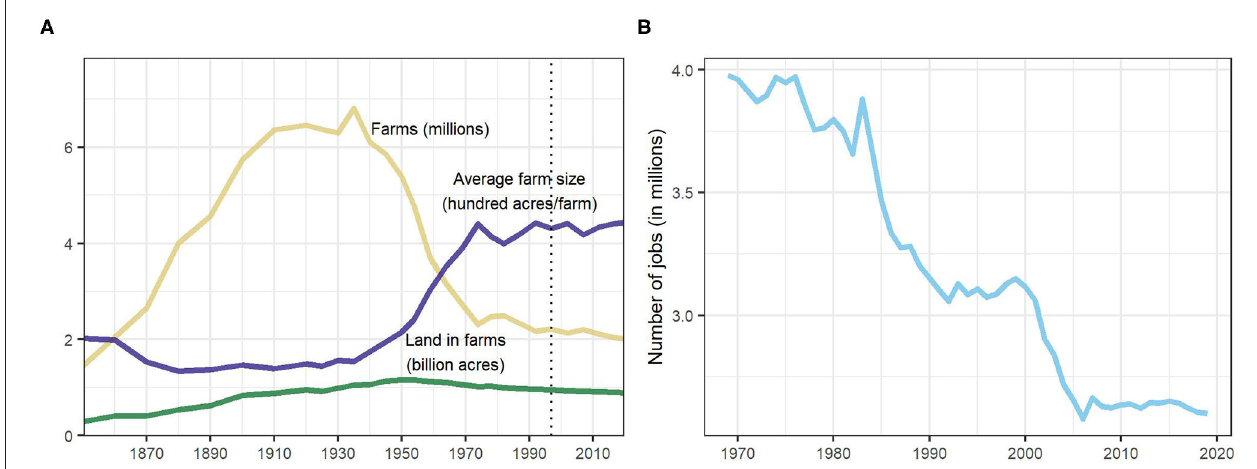
FIGURE 2 | (A) US farms (in millions ), land in farms (in billion acres ), and average farm size (in hundred acres/farm ) from 1850 to 2017. The vertical line in 1997 reflects USDA NASS adjustments for under-coverage. Data: USDA ERS, compiled by R. Hoppe. (B) Number of agricultural jobs from 1969 to 2019 13 . Data: US BEAa.